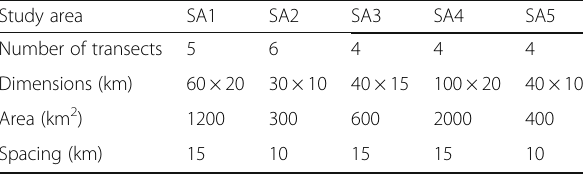
Table 1 Sampling design for the five deforestation patterns Study